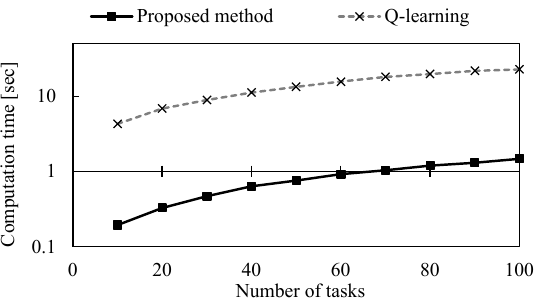
Figure 14. Comparison of computation times on dynamic problems.